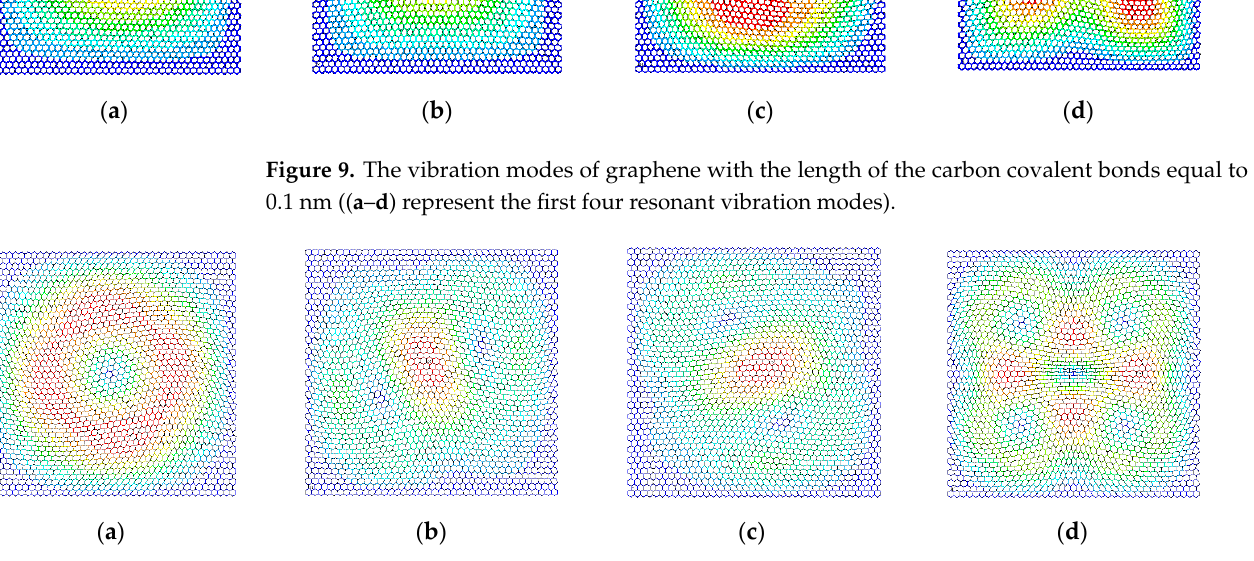
Figure 10. The vibration modes of graphene with the length of the carbon covalent bonds equal to 0.4 nm (( a – d ) represent the first four resonant vibration